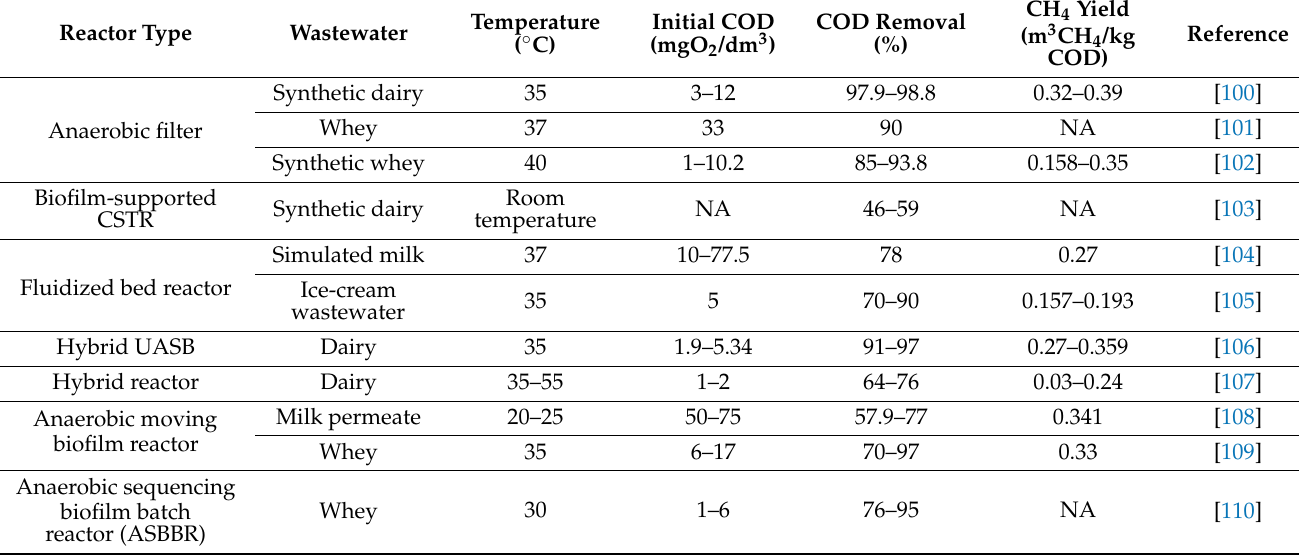
Table 4. Digestion performance vs. temperature